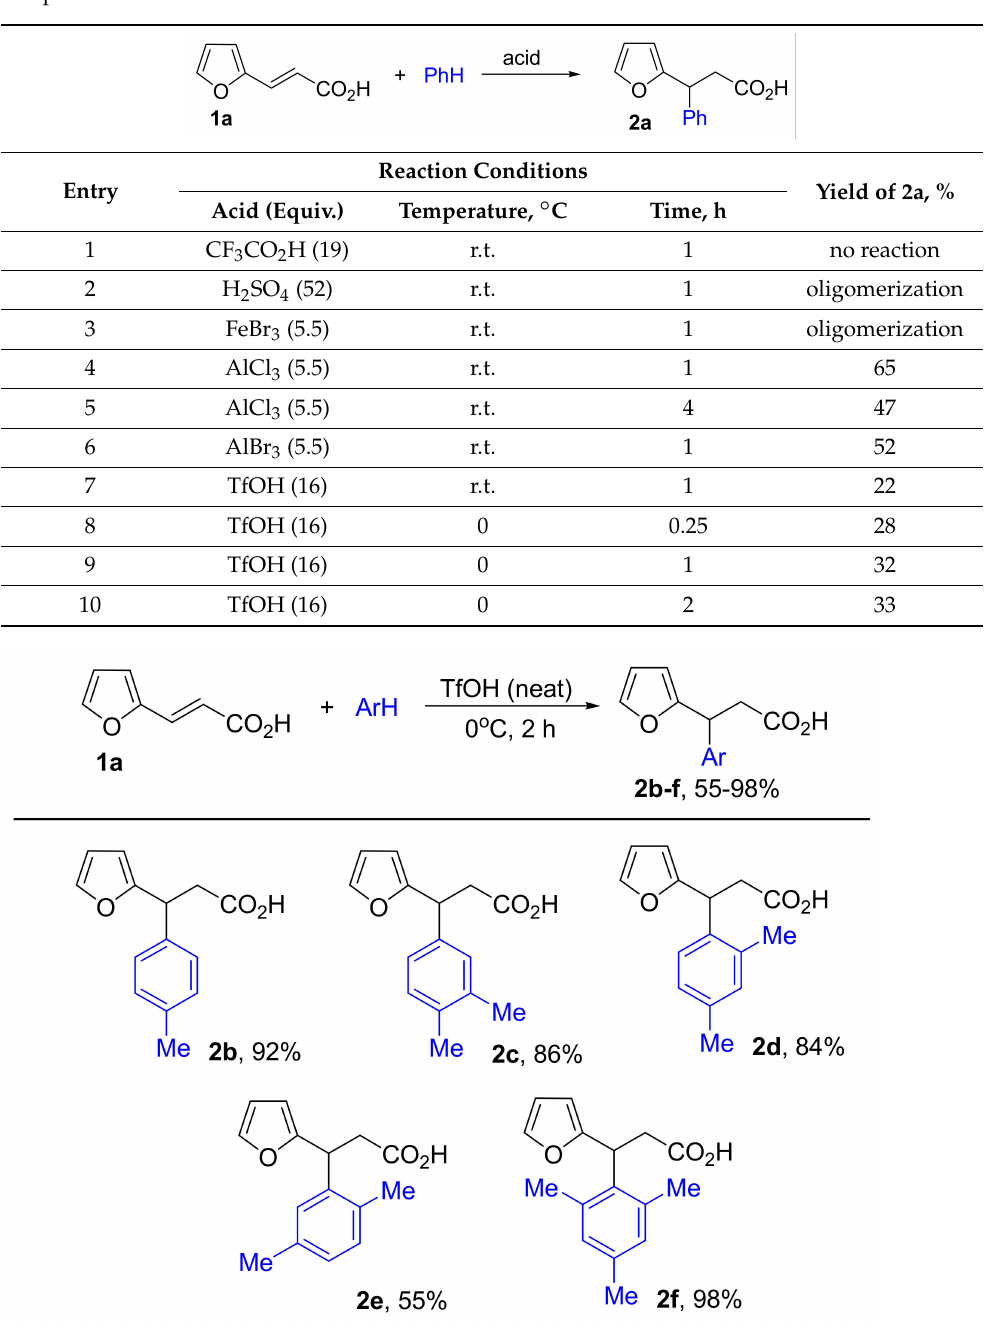
Reaction Conditions